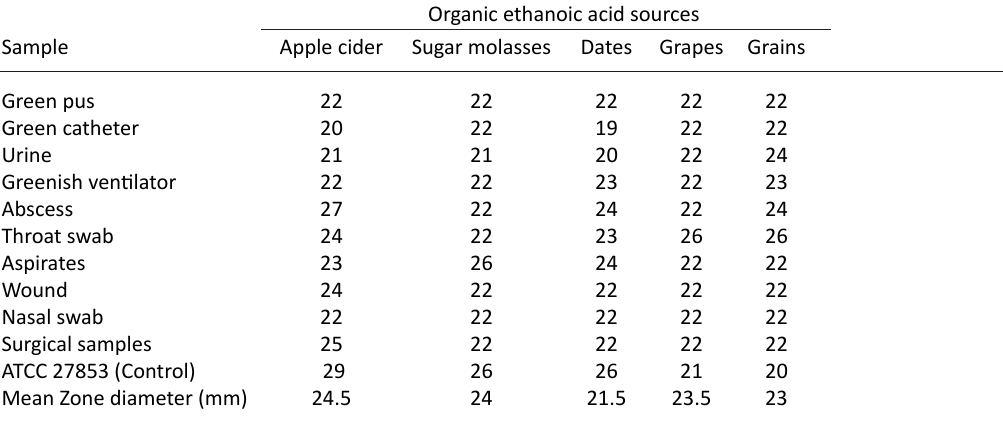
Table 4. Comparison of minimum inhibitory concentrations of organic ethanoic acids among Pseudomonas aeruginosa isolates. Organic ethanoic acids (µg/mL) Sample Apple cider Sugar molasses